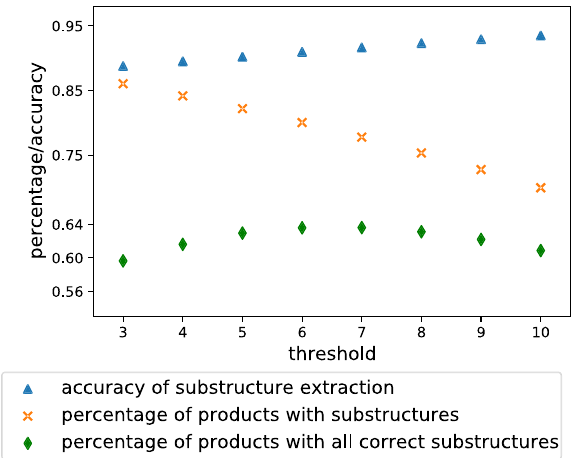
Fig. 3 | Substructure extraction analyses. The accuracy and the percentage of products with substructures under different